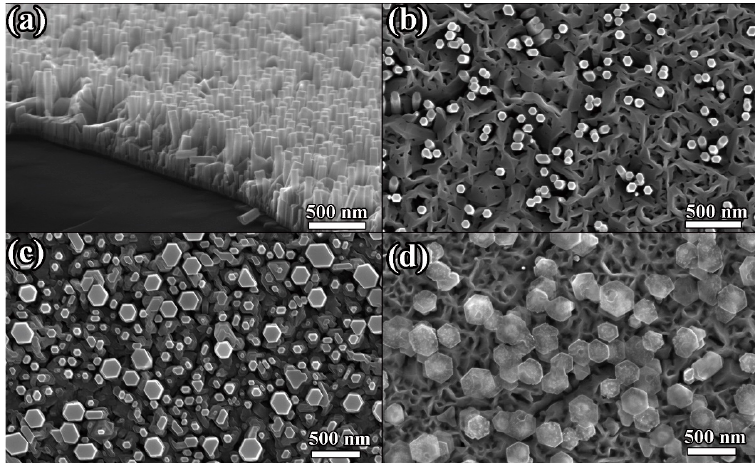
Figure 4. FESEM images of InGaN nanostructures on Si (111) substrates. ( a ) Side view of InGaN nanorods; ( b ) Top view of the In 0.1 Ga 0.9 N nanorods; ( c ) Top view of the In 0.3 Ga 0.7 N nanorods; ( d ) Top view of the In 0.5 Ga 0.5 N nano-mushrooms.